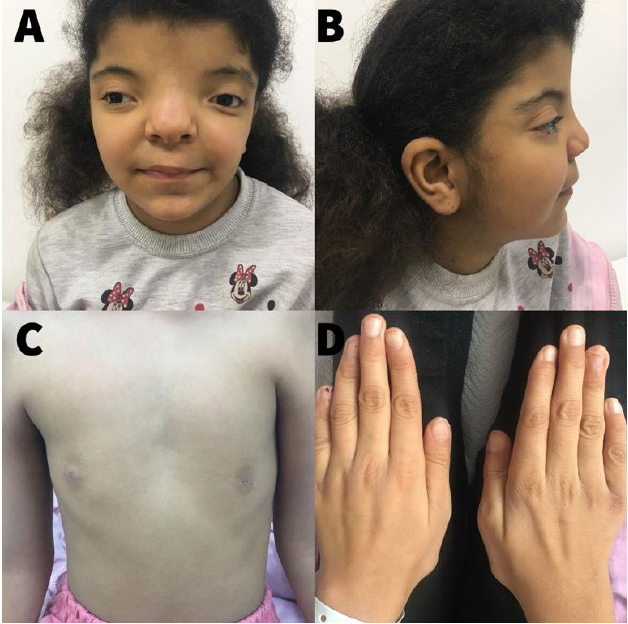
Figure 2. The abnormal appearance of the girl patient. ( A ) Syndromic facial appearance of the girl patient. ( B ) Brachycephaly and low-set ear. ( C ) Abnormal areolar leveling. ( D ) Longitudinal bumps and splitting on fingernails.